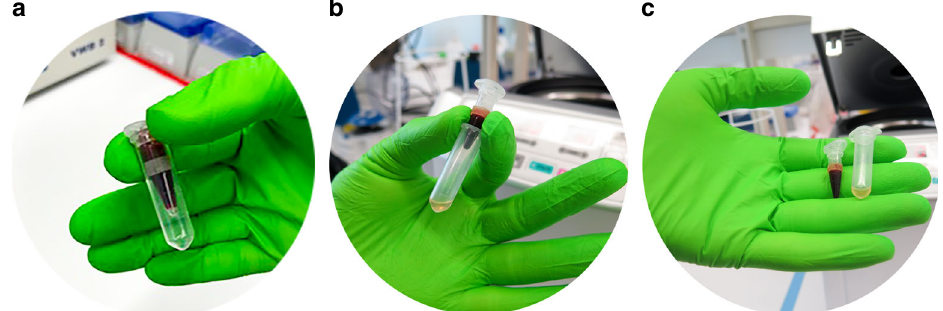
Fig. 5 A con fi guration of interlocking dispensing analyzer assembled to automate blood plasma separation in laboratories. Interlocking dispensing analyzer for blood plasma separation is constituted of a micro-dispenser made of a safe-lock Eppendorf tube that is interlocked into a larger safe-lock collection tube. a An interlocking dispensing analyzer before inserting in centrifuge machine, b after centrifugation according to the standard protocols for 20 min, c blood cells in the micro-dispenser and blood plasma in a safe-lock